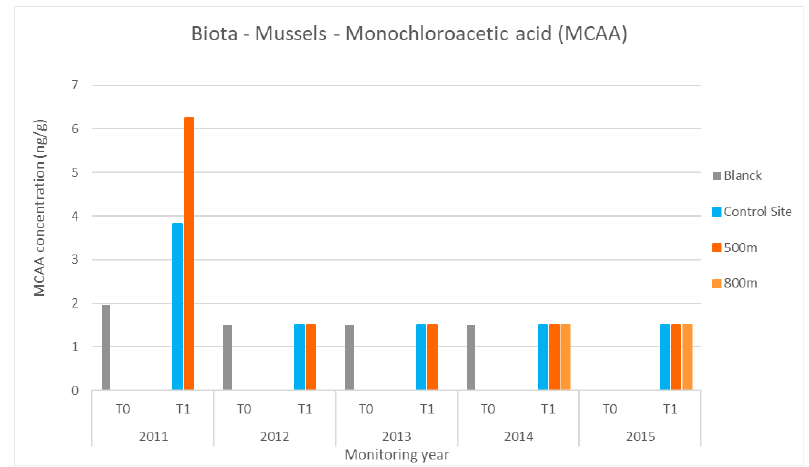
Figure 11. MCAA concentrations in mussel samples collected from 2010 to 2015 at sites located near the LNG terminal and at control site in the Northern Adriatic Sea.